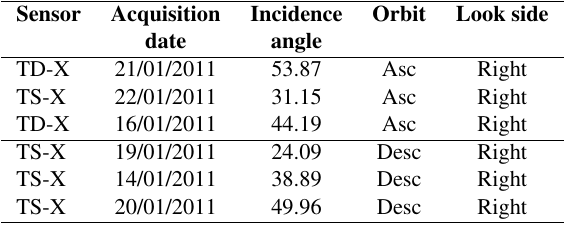
Table 1: TerraSAR-X imagery features